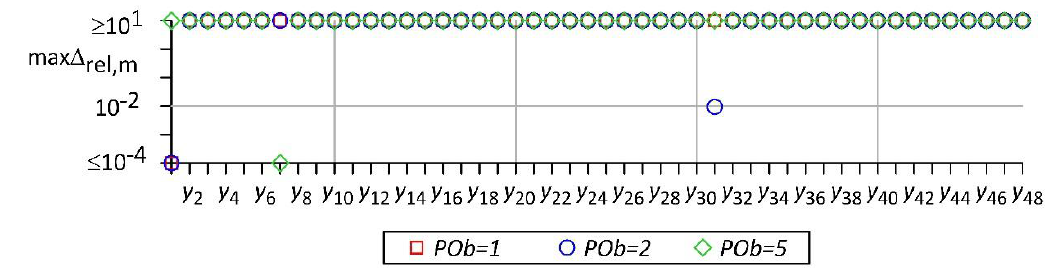
Figure 13. The maximum relative error of the probabilistic moments of the approximations with the extreme value of the correlation coefficient for poly = 1, α max *( x ) = 0.30, different degrees of the base reference POb and the groups of functions used to generate discrete data.